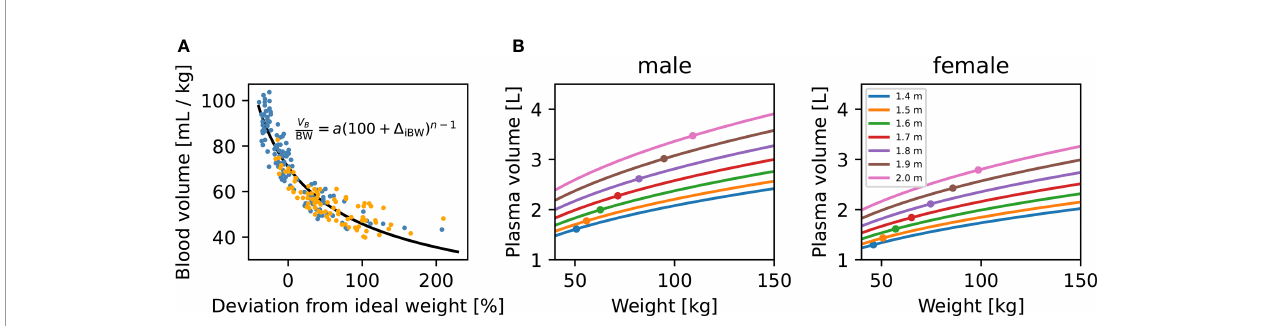
FIGURE 3 | Blood volume ( V B ) dependence on body weight ( BW ), height ( H ), and sex. (A) Blood volume submodel. Data relating blood volume per mass (27) to the deviation from ideal weight, fi tted by least-squares (black curve) with our two-parameter V B submodel. Individual patients are shown as colored dots (blue: M, orange: F). Our V B submodel equation is shown inside the panel. (B) Model predictions for plasma volume ( V P ) of M and F patients. The predicted V P for male (left panel) and female (right panel) patients are plotted against patient BW . Predictions for patients of different heights, ranging from 1.4 to 2 m, are shown as separate curves. Ideal patient weights for the corresponding sex and H are shown as dots. For converting V B to V P , we assume a hematocrit of 0.45 for male and 0.4 for